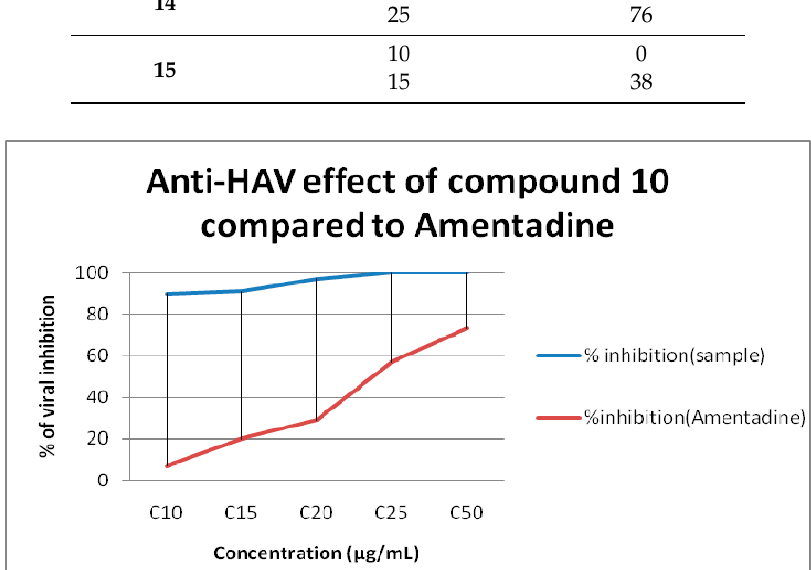
Figure 2. Anti HAV activity of compound 10 compared to amentadine as positive control, C: concentration.